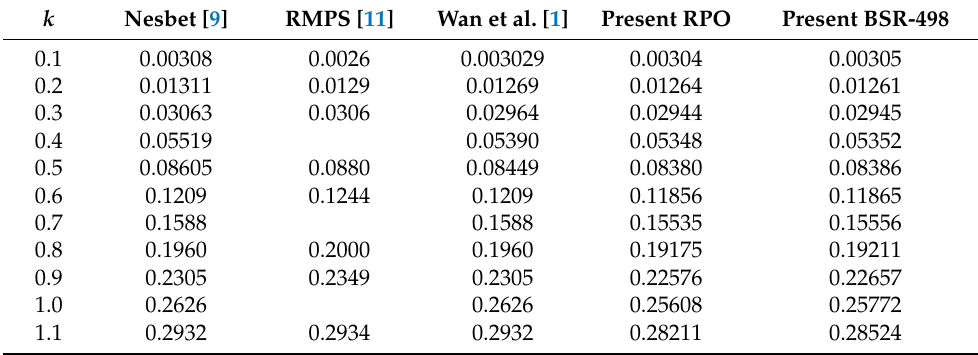
Table 2. P -wave phaseshift as a function of linear momentum k for infinite nuclear mass.